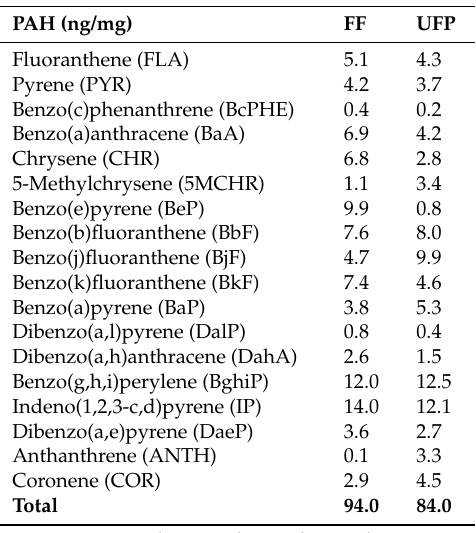
Table 2. PAH composition of FF and UFP quantified by